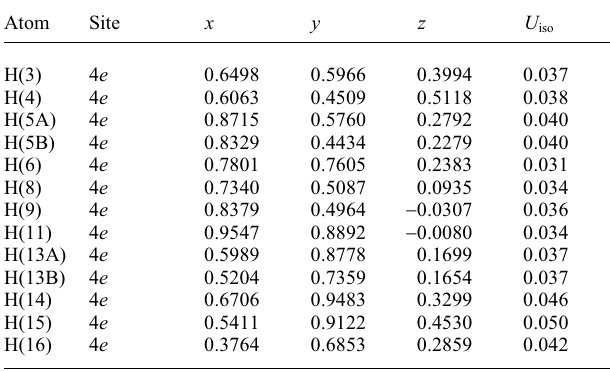
Table 2. Atomic coordinates and displacement parameters (in Å 2 )